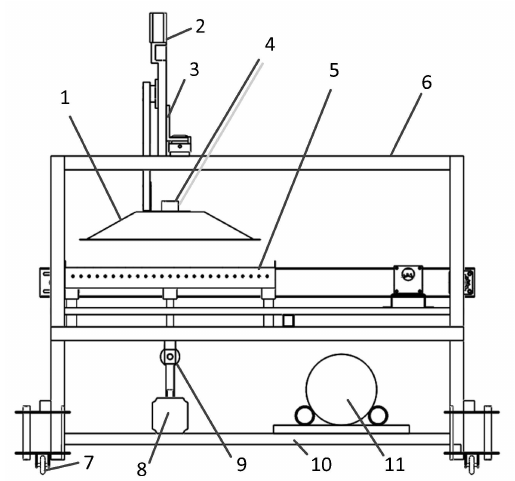
Figure 1. Air suction vibrating disc seed metering device structure diagram. 1. sucker 2. stepper motor 3. screw guide 4. air duct interface 5. seed tray 6. Frame 7. moving wheel 8. servo motor 9. crank mechanism 10. base 11. high-pressure